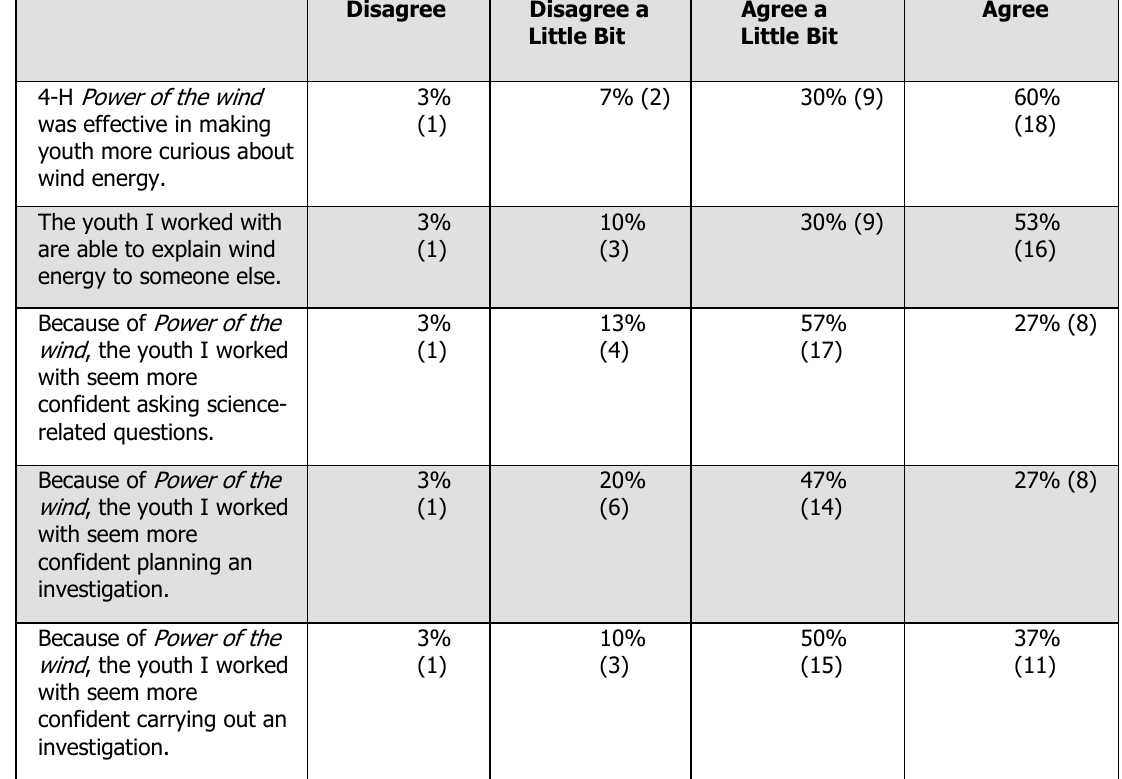
Youth Abilities in 4-H Science from Adult Perspective